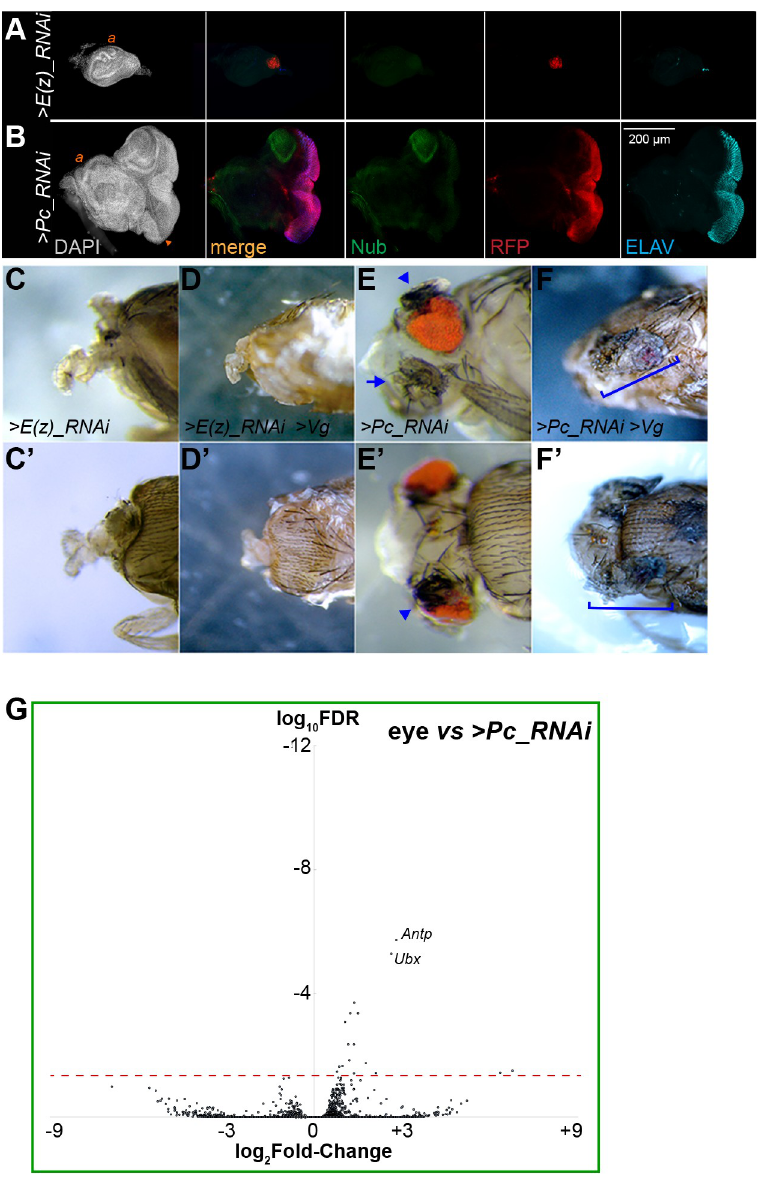
Fig 7. Effects of reduced PRC1 and PRC2 on direct reprogramming and cell proliferation. ( A-B ) Eye-antennal discs with eyGAL -induced expression of RFP and RNAi constructs directed against E(z) ( A ) or Pc ( B ) transcripts. Both discs are immunostained for the wing-specific Nub protein and for ELAV. The eye and antennal portions of discs are greatly reduced with E(z) knockdown, while Pc knockdown results in overgrowth of the eye portion and expression of Nub at the dorsal edge of the disc. ( C-D ) Heads of dissected dying pharate pupae with E(z) knockdown ( C, C’ ) or E(z) knockdown and Vg production ( D, D’ ). Loss of E(z) ablates all tissue derived from the eye-antennal disc including the head capsule and eyes, without affecting mouthparts. ( E-F ) Heads of dissected dying pharate pupae with Pc knockdown ( E, E’ ) or Pc knockdown and Vg production ( F, F’ ). Loss of Pc induces ectopic wing-like structures at the dorsal edges of eyes (arrowhead) and transforms antennae into legs (arrow). Vg production with Pc knockdown results greatly reduced eyes and expanded and flattened wing-like structures (bracket). ( G ) Volcano plot of differentially- expressed genes between wildtype ( w 1118 ) eye imaginal discs and eye discs with Pc knockdown. Antp and Ubx are the most significantly differentially-expressed.